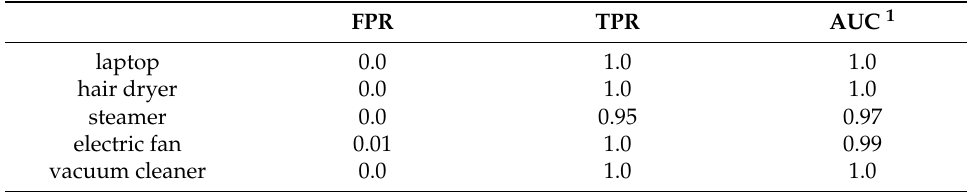
Table 3. Obtained TPR values vs. FPR values for ROC curves by the well-trained and -tested feed- forward ANN applied on the class-imbalanced training data in this experiment, where the AUC values are also shown for each class.